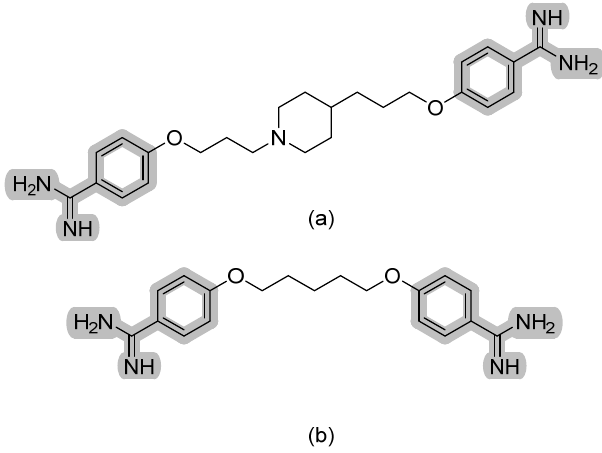
Figure 4. The chemical structures of ( a ) T-2307 and ( b ) pentamidine. The characteristic aryldiamidine moiety is highlighted in grey.